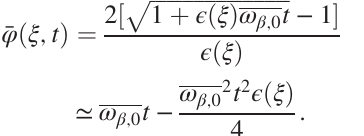
ffiffiffiffiffiffiffiffiffiffiffiffiffiffiffiffiffiffiffiffiffiffiffiffiffiffi 1 þ ϵ ð ξ Þ ω